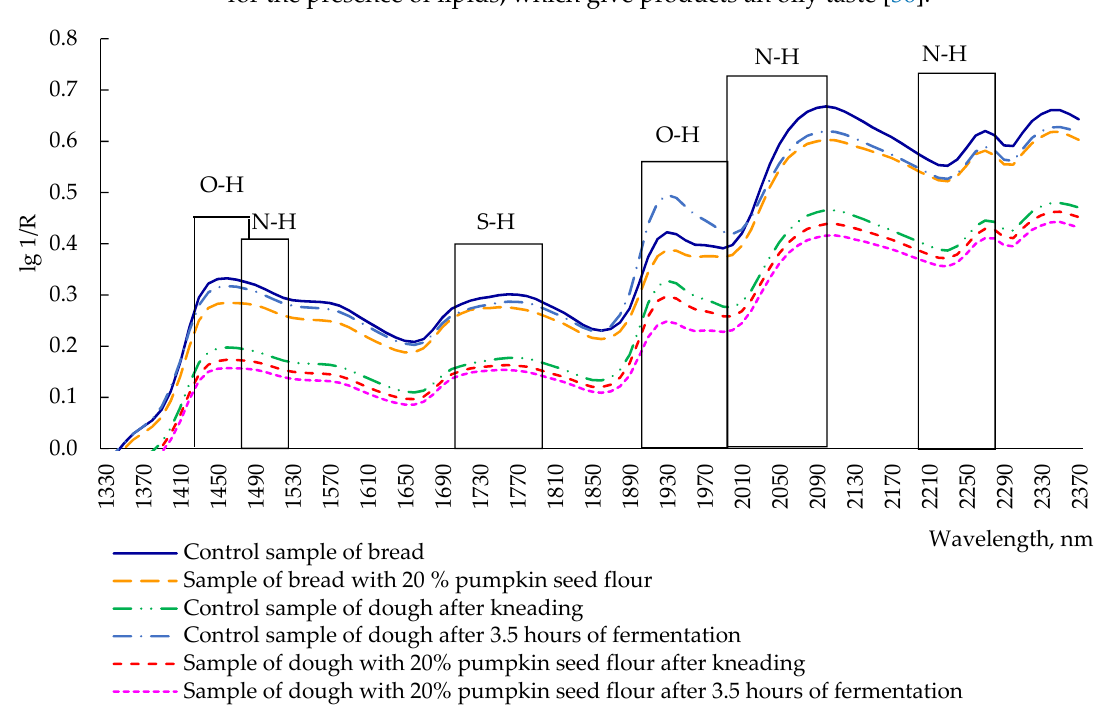
Figure 6. Changes and redistribution of structural groups in bread and dough after kneading and after 3.5 h of fermentation.